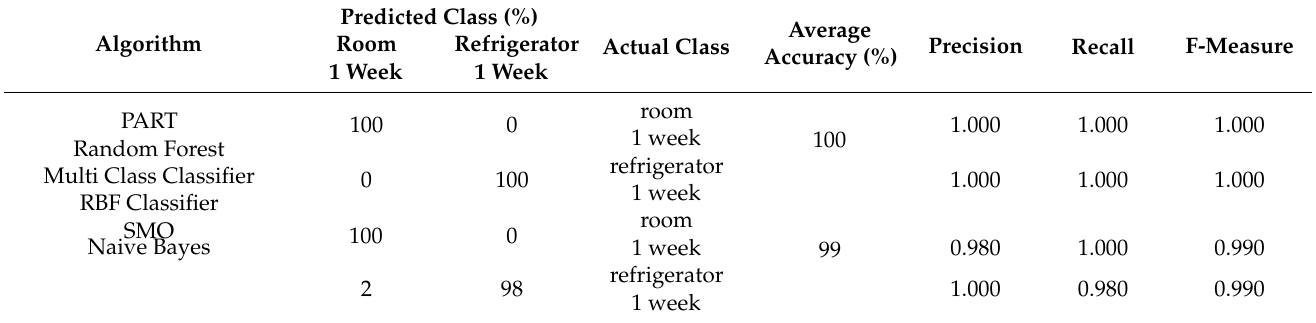
Table 3. The accuracies and other performance metrics for classifying red currants stored at room temperature for one week and stored in the refrigerator for one week based on selected textures from color channels R , G , B , L , a , b , X , Y , and Z .